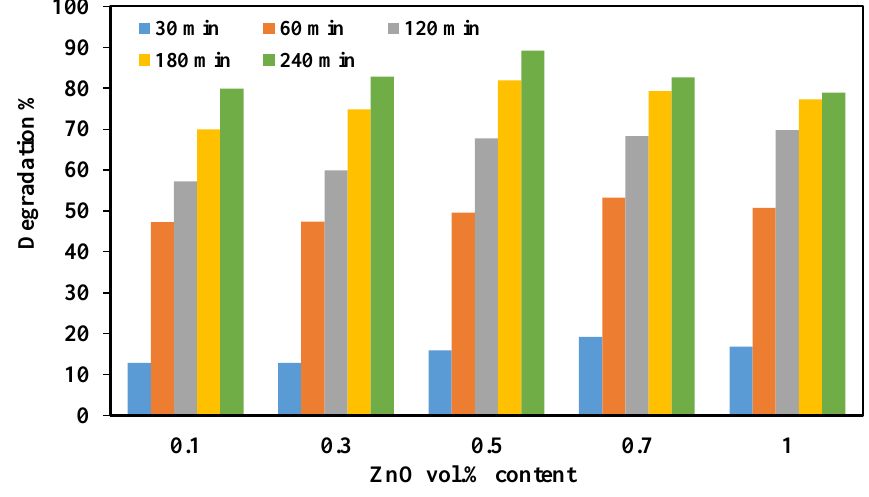
Figure 5: Photodegradation efficiency of MB dye (5ppm) by ZnO/ sawdust /epoxy nanocomposite with different ratios of